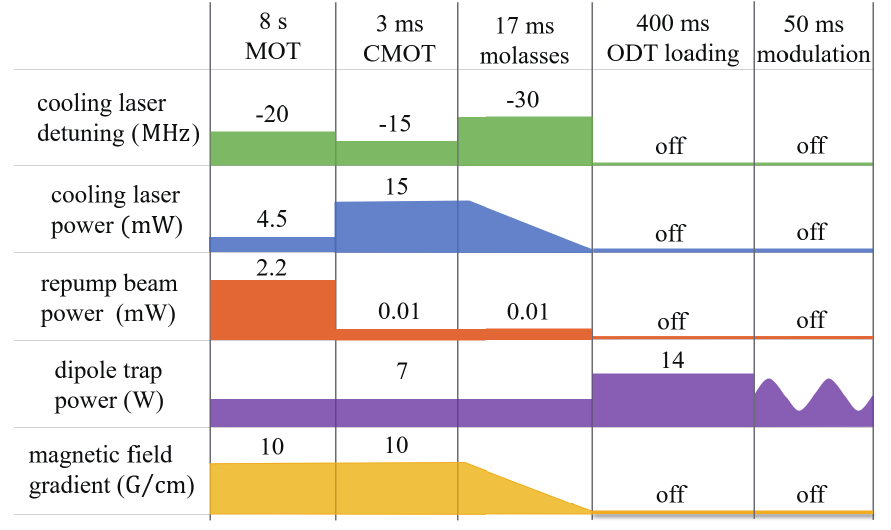
Figure 2. Experimental sequence of parametric excitation of atoms in the ODT. The axes are not to